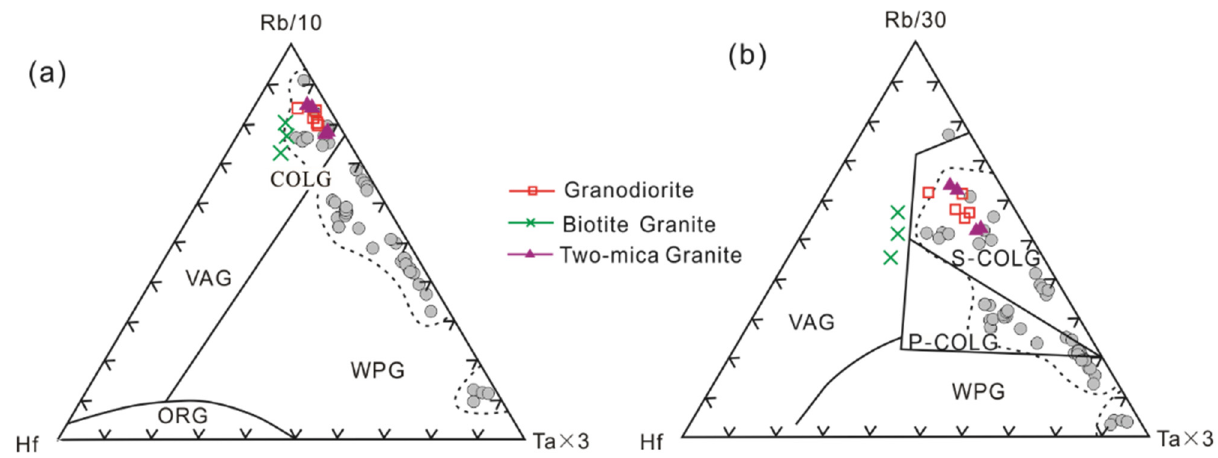
Figure 10. Tectonic discrimination diagrams for Zhuxi granites of the Jingdezhen area. ( a ) Rb/10–Hf–(3Ta); ( b ) Rb/30–Hf–(3Ta) (after [107]). VAG—volcanic arc granite; WPG—within–plate granite; ORG—oceanic ridge granite; COLG—collisional granite; S–COLG—syn–collisional granite; L–COLG—late–collisional granite; P–COLG—post-collisional granite. The circles in the diagrams denote published data for the Zhuxi granites [38,42,43].